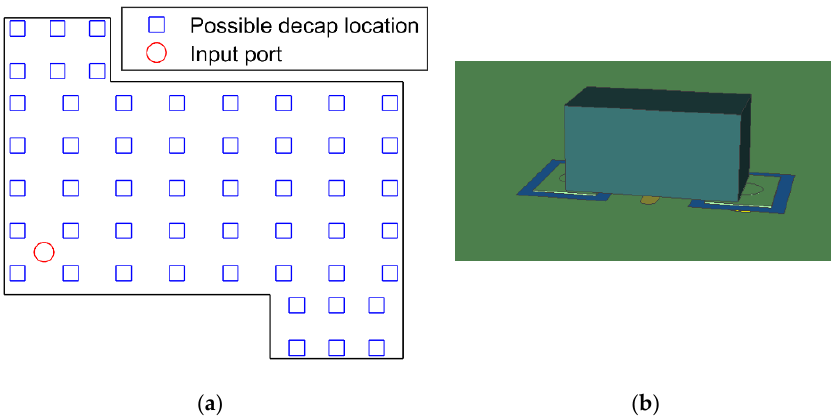
Figure 9. ( a ) Possible positions for the decaps over the board and ( b ) new configuration for the capacitor in DF PI having no traces for the connection with the vias.